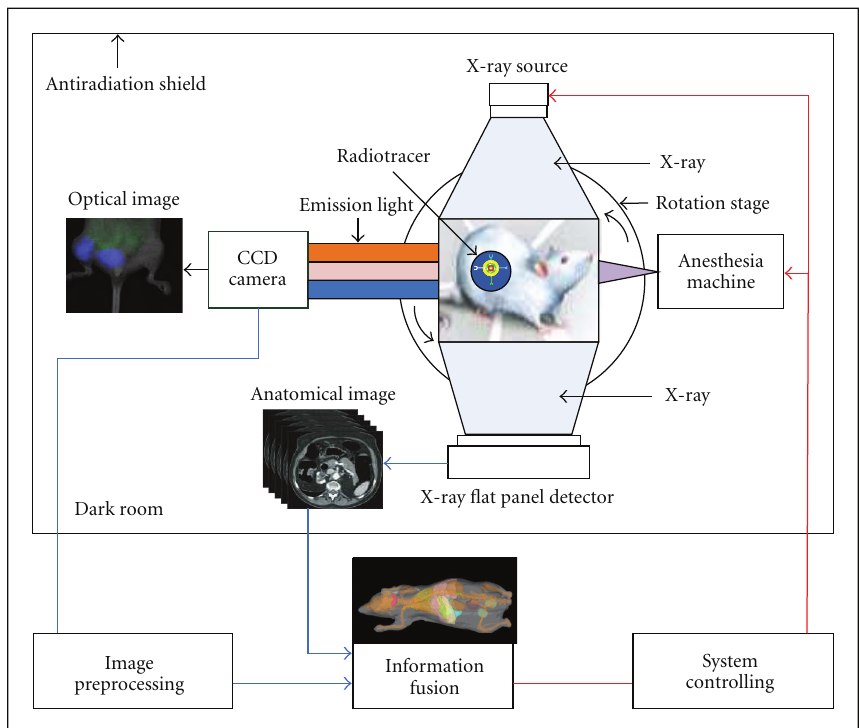
Figure 1: Schematic diagram of our imaging system. In vivo imaging system consists of a CCD camera, small animal anesthesia machine, a Micro-focus X-ray source, an X-ray flat panel detector, a rotation stage, and an antiradiation shield.